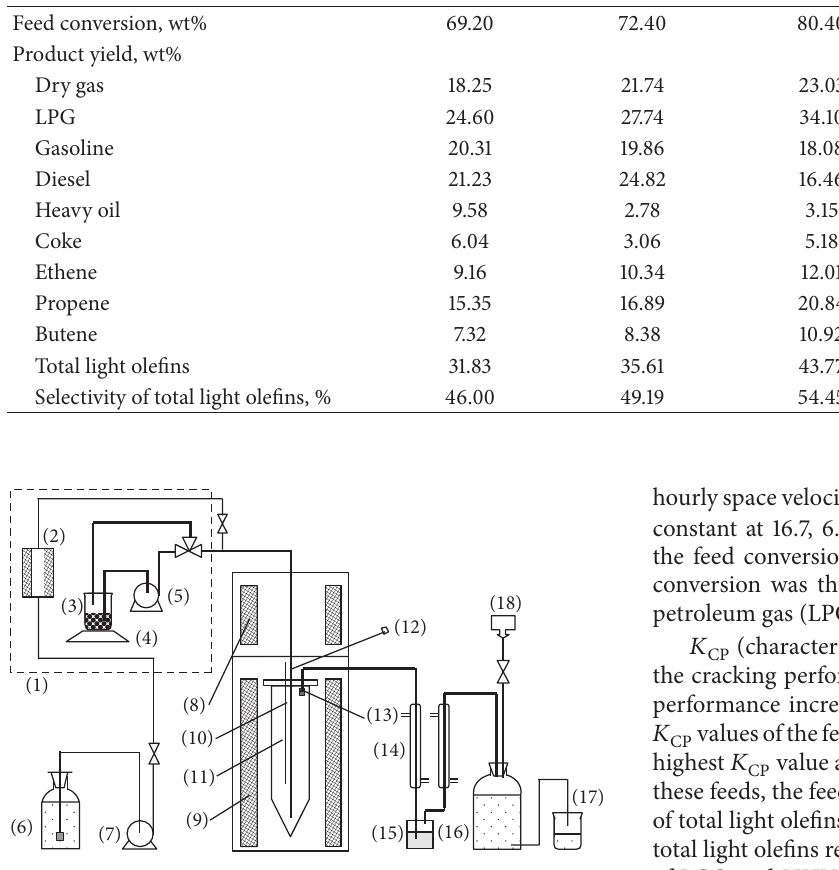
Figure 1: Diagram of the experimental setup ((1) constant temper- ature box; (2) steam furnace; (3) feedstock; (4) electronic balance; (5) oil pump; (6) water tank; (7) water pump; (8) preheater; (9) reactor furnace; (10) thermocouple; (11) reactor; (12) inlet and outlet of catalysts; (13) filter; (14) condenser; (15) collecting bottle for liquid products; (16) gas collection vessel; (17) beaker; (18) gas sample